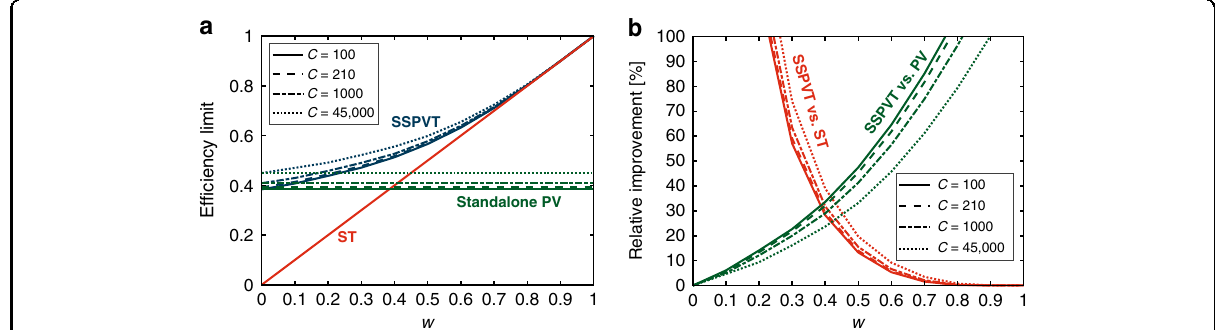
Fig. 4 a Ef fi ciency limits of SSPVT, ST and standalone PV, and b relative improvement of SSPVT compared to ST and PV as a function of w for different C = 100, 210, 1000,